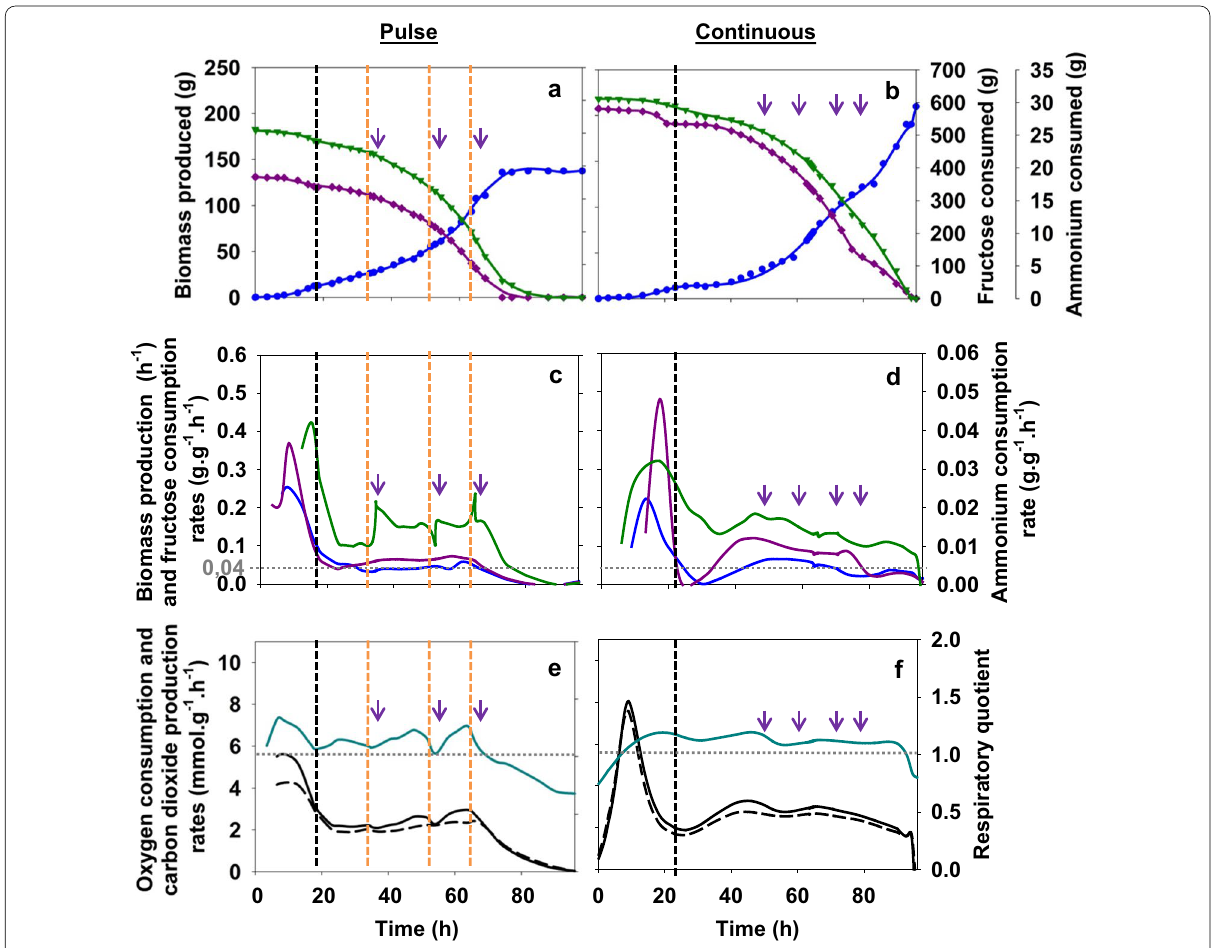
Fig. 1 Cumulated biomass production ( ), fructose ( ) and ammonium ( ) consumption during culture of the strain Re2133/pCB1 with kanamycin: with fructose pulses ( a ) and continuous feeding ( b ). Growth rate ( ), fructose ( ) and ammonium ( ) consumption rates during Re2133/pCB1 culture of the strain Re2133/pCB1 with kanamycin: with fructose pulse ( c ) and continuous feeding ( d ). Respiratory quotient ( ), oxygen consumption ( ) and carbon dioxide ( ) production rates during culture of the strain Re2133/pCB1 with kanamycin: with fructose pulse ( e ) and continuous feeding ( f ). Black vertical lines represent the beginning of the fed-batch phase and orange vertical lines represent fructose pulses. Purple arrows represent additions (kanamycin, 100 mg L − 1 ; elements and phosphorus ·